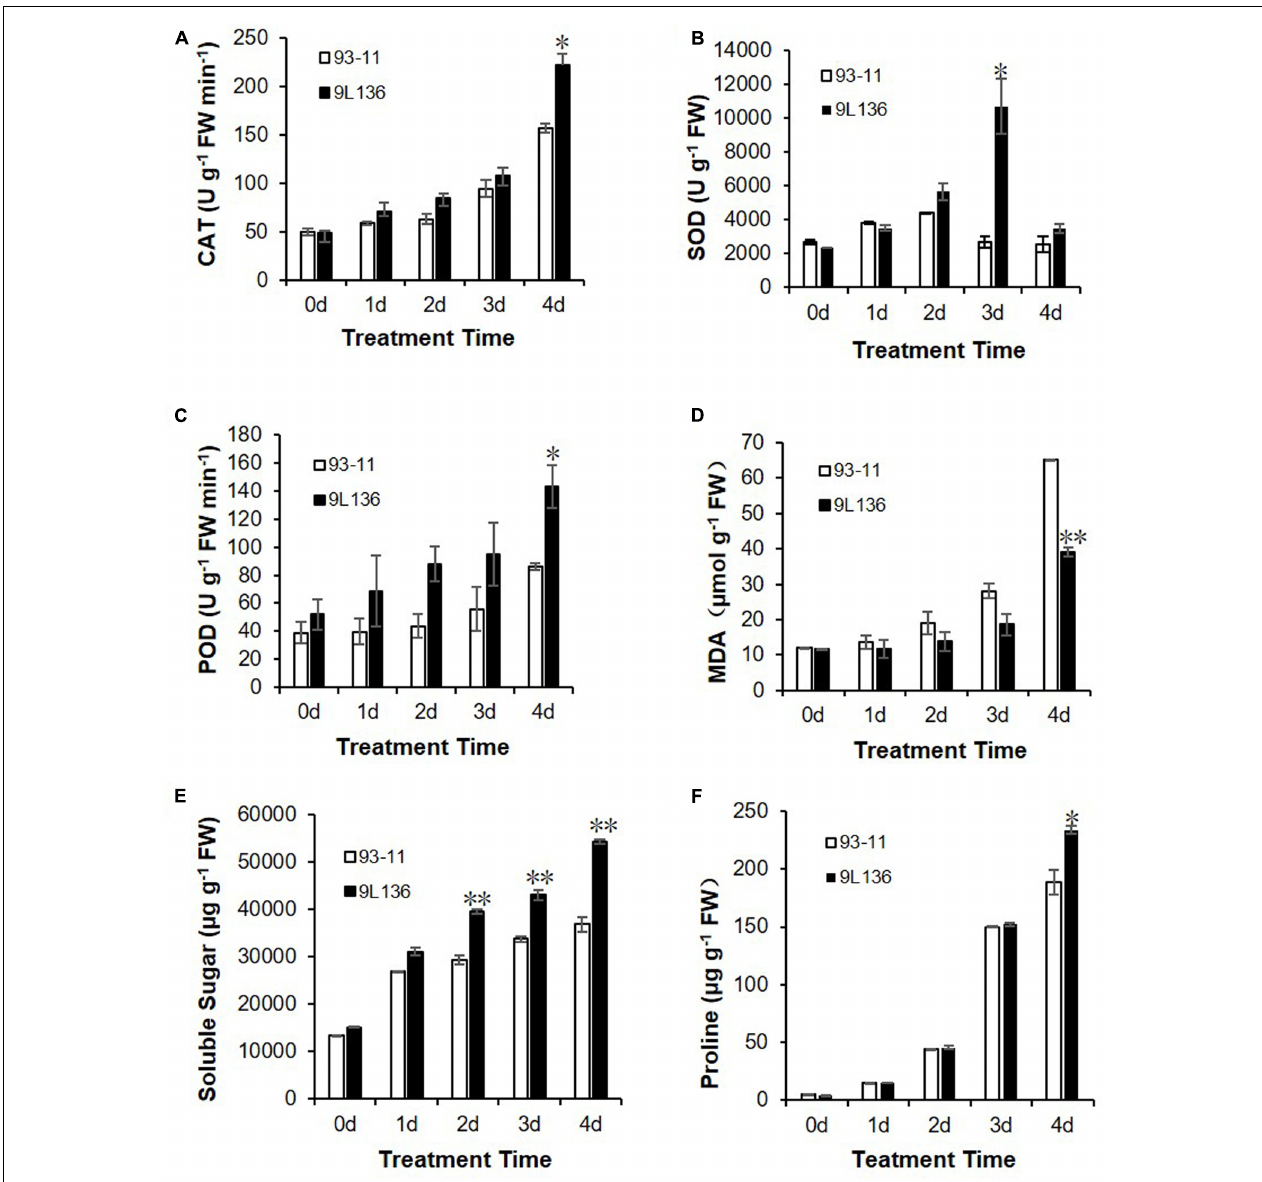
FIGURE 3 | Comparison of physiological characteristics between salt-tolerant line 9L136 and recurrent parent 93-11 under salt stress conditions (125 mM NaCl). Physiological characteristics included the activities of catalase (CAT) (A) , superoxide dismutase (SOD) (B) , peroxidase (POD) (C) , and malondialdehyde (MDA) (D) , and the contents of soluble sugars (E) and proline (F) . Data are means ± standard deviation with three replicates. Asterisks represent significant differences between 93-11 and 9L136 using Student’s t- test: ∗ P < 0.05 and ∗∗ P <